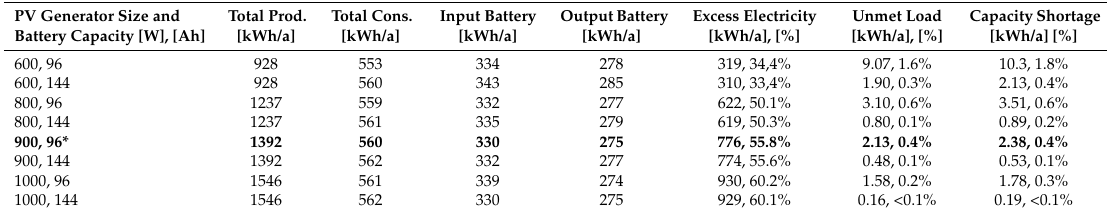
Table 6. Results of sensitive analysis based on shown PV battery combinations.